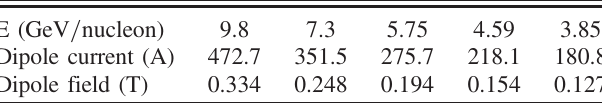
TABLE I. BES-II beam energies and corresponding dipole currents and field strength.